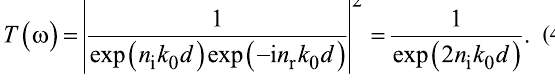
where n r and n i are the real and imaginary parts of the refrac- tive index, respectively. Equation 3 can be simplified as